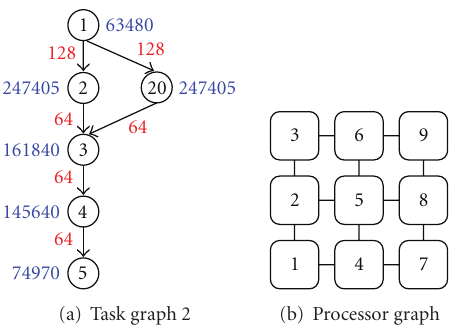
Figure 8: Modelling example for an application and NoC processor array.